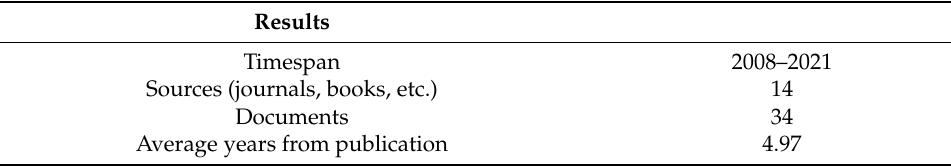
Table 2. Main information about selected